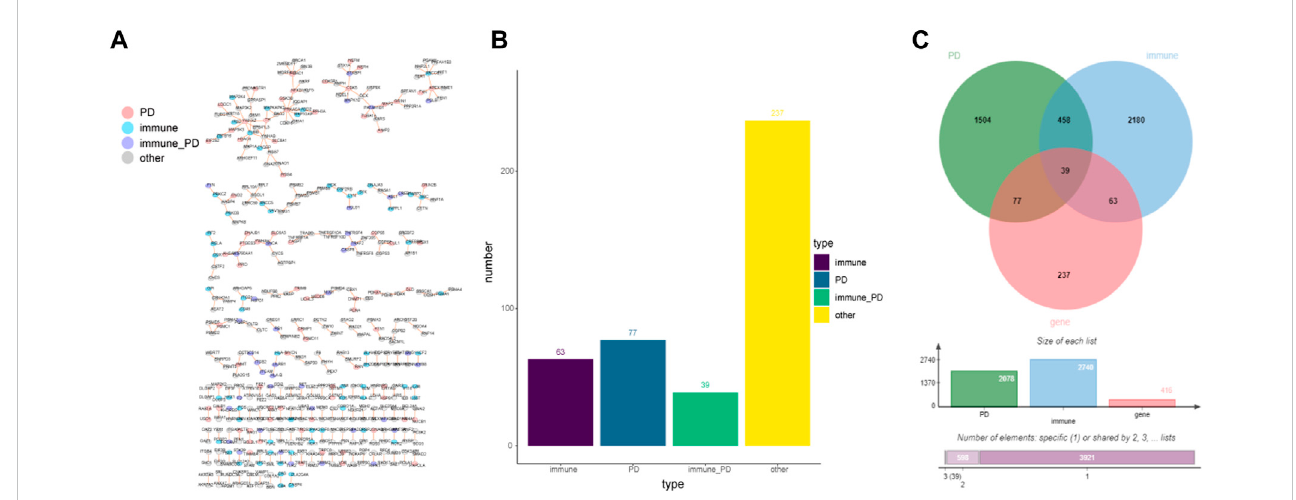
FIGURE 1 The immune- or PD-directed neighbor co-expressed network (IOPDNC network). (A) The global IOPDNC network was constructed to identify a common network by the GSE49036 dataset and HPRD database. (B) The histogram chart of the common genes in the IOPDNC network. (C) The Venn diagram showed the intersections of immune-related genes, PD-related genes, and common network